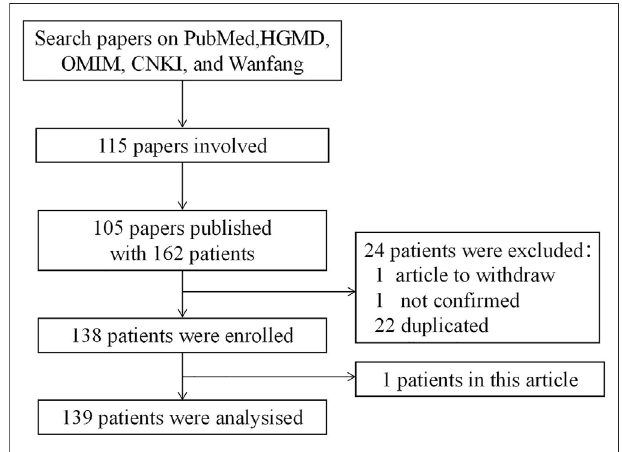
FIGURE 2 | Case-screening fl